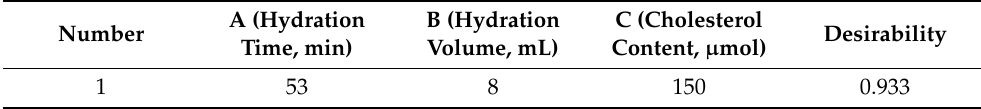
Table 3. Desirability criteria and predicted values for the